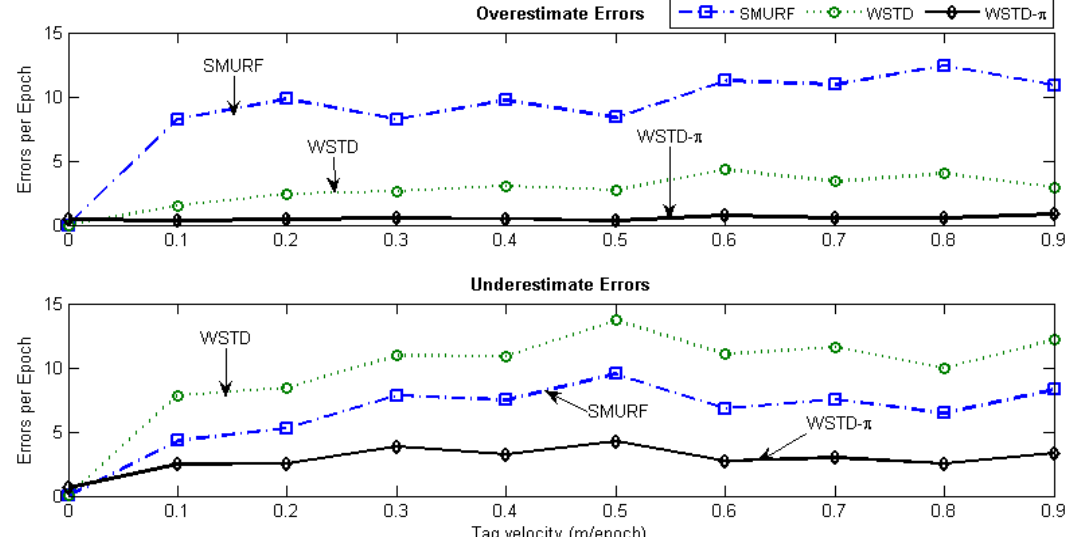
Figure 17. Variable window schemes overestimate and underestimate error contributions as the tags’ velocity is